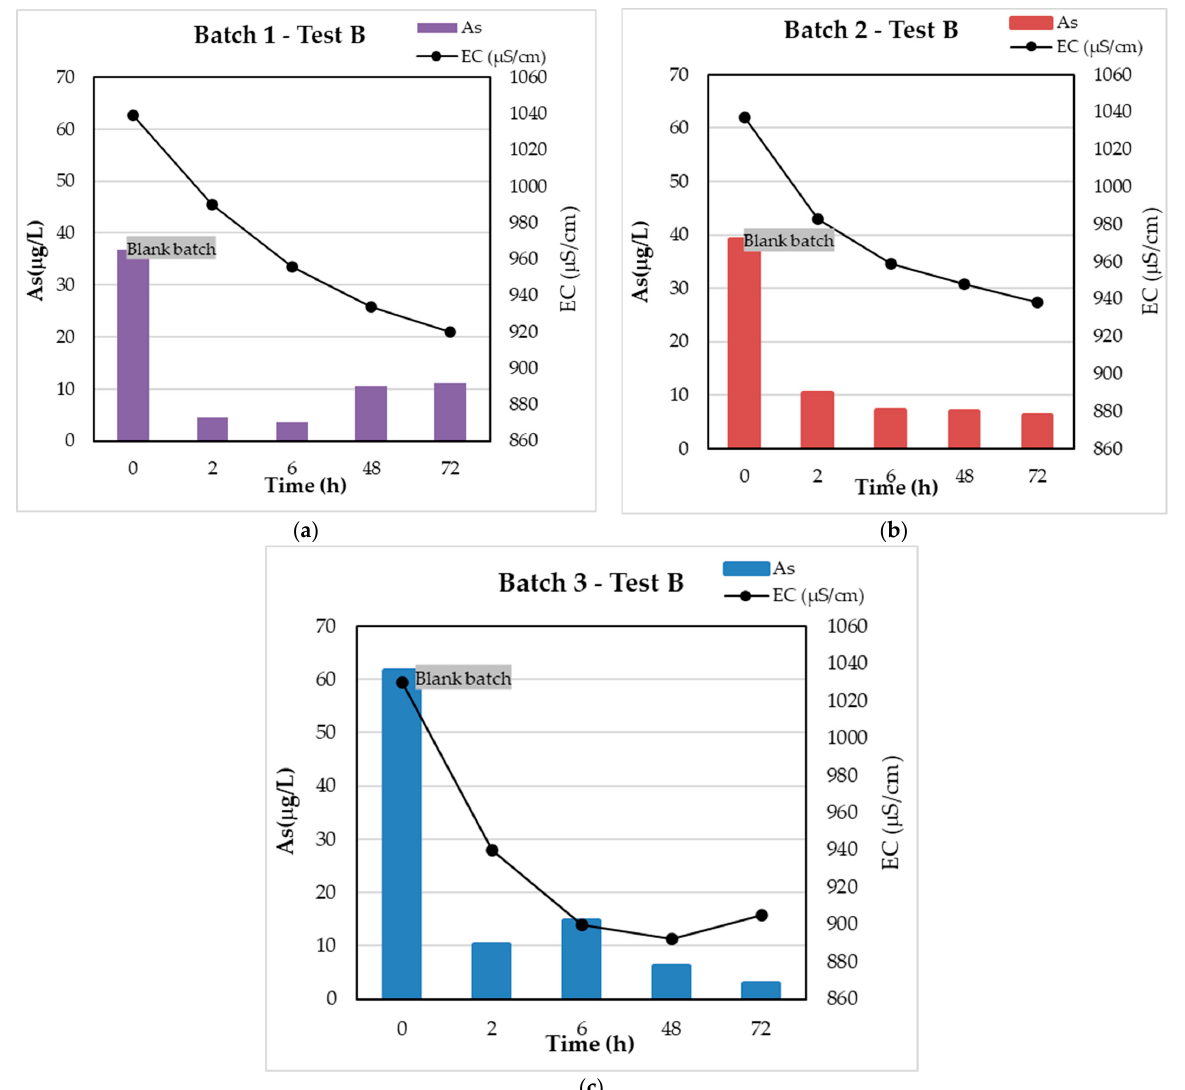
Figure 8. As and EC trend (Test B): ( a ) Batch 1, ( b ) Batch 2 and ( c ) Batch 3 . Table 7. The amount of adsorbed As at equilibrium in mg ∗ g − 1 for Test B .